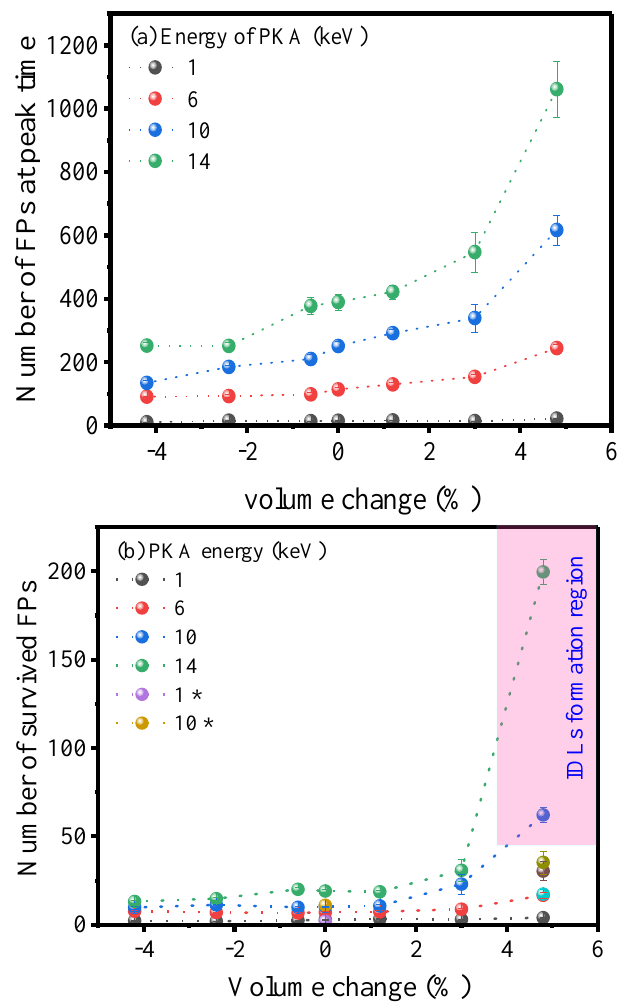
Figure 3. ( a ) Estimated peak number of FPs for various PKA energies as a function of applied hydrostatic strain ( b ) number of survived defects after 20~30 ps, the pink region is the region where IDLs were found to occur.